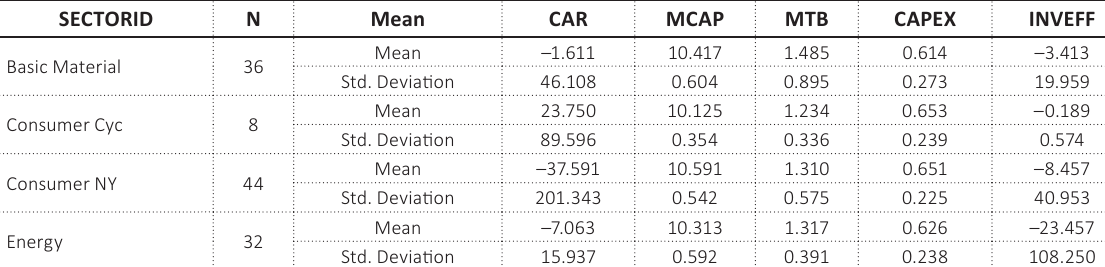
Table 3. Descriptive statistics (CAR, MCAP, MTB, CAPEX, INVEFF) by